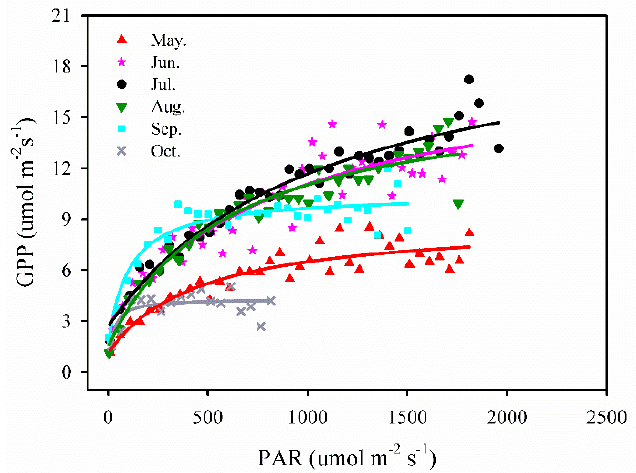
Figure 8. Responses of gross primary production (GPP) to photosynthetically active radiation (PAR) from May to October across two years, 2015–2016, at the study site. GPP used in curve fitting was averaged in 50 μ mol m − 2 s − 1 PAR bins.